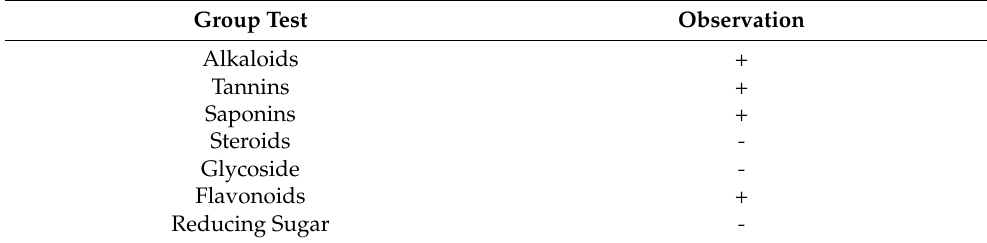
Table 1. Phytochemical screening of ethanol extract of C. sinensis . Group Test Observation Alkaloids + Tannins + Saponins + Steroids - Glycoside - Flavonoids + Reducing Sugar